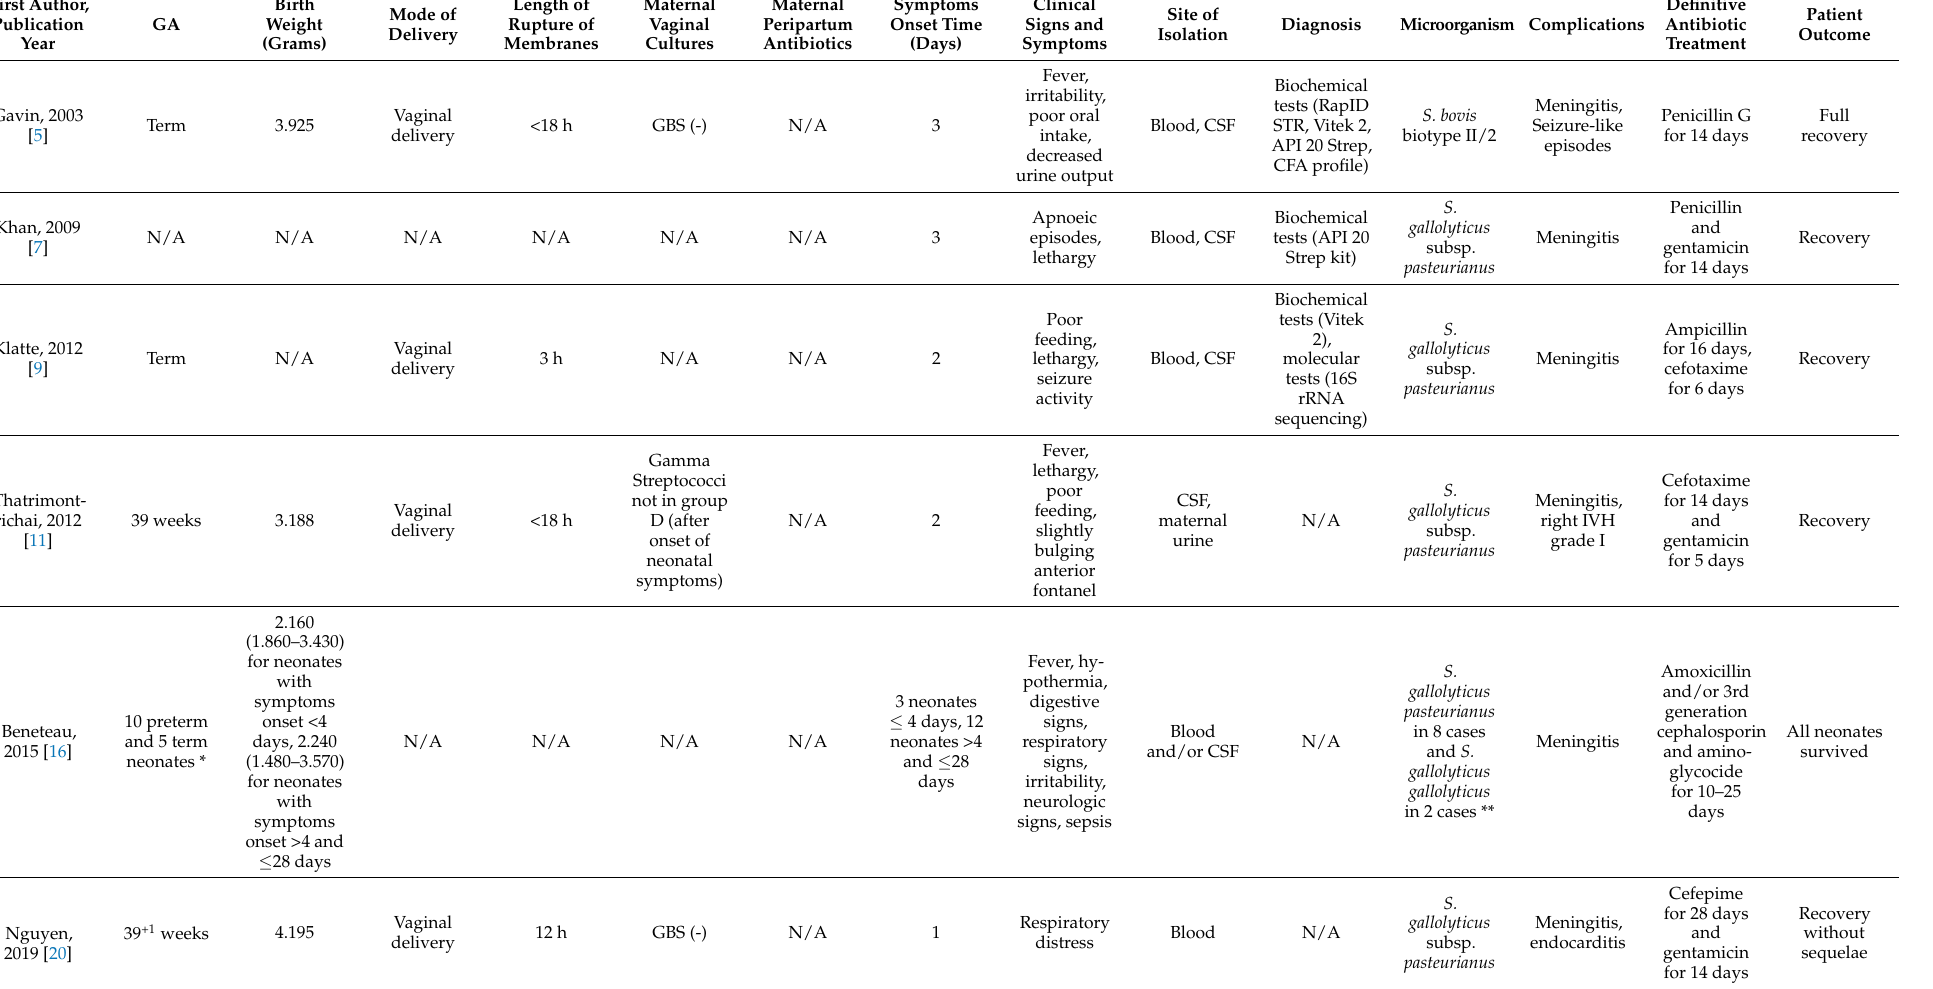
Table 1. Characteristics of cases of early-onset sepsis caused by S. gallolyticus or S. bovis biotype